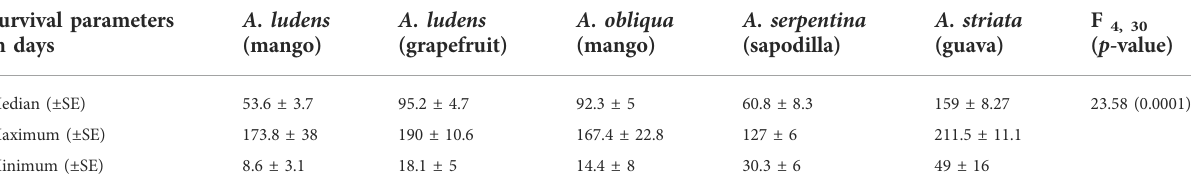
TABLE 3 Means of median, maximum, and minimum survival days ±SEM of the different Anastrepha spp. in the fi eld (females and males together). Survival parameters in days